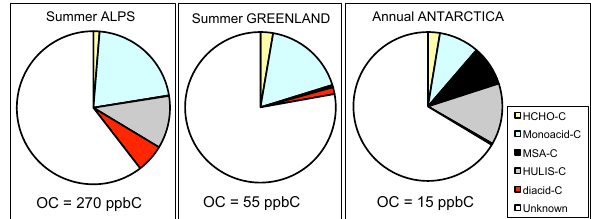
Fig. 3. From left to right: chemical composition of OC present in recent summer snow layers at the Col du Dˆome and Summit sites, and in recent annual snow layers at Concordia (see Sect. 4). Here, OC values refer to DOC at Col du Dˆome, DOC, or TOC within 10% uncertainty in Greenland and Antarctica (see Sect. 3.2.1). The identified organic species include formaldehyde, C 1 –C 3 monocar- boxylic (formic, lactic, acetic, glycolic, and glyoxylic) acids, MSA, C 2 –C 5 dicarboxylic (oxalic, malic, malonic, succinic, and glutaric) acids, HULIS, and the remaining unidentified fraction of OC (see Sect.